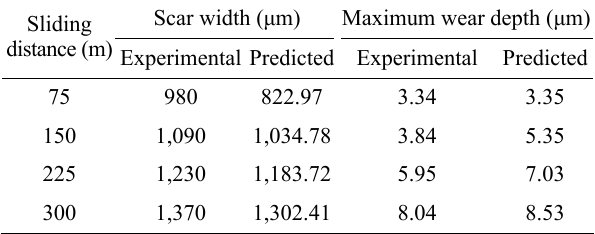
Table 2 Comparison of numerical prediction and experimental results for wear scars on the flat specimen.